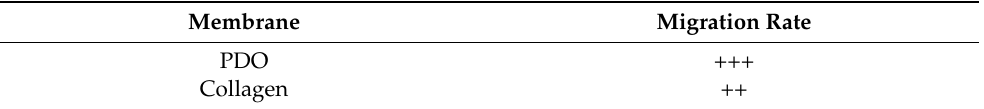
Table 3. Rate of hASC migration from the PDO and collagen membranes. ( − ) No migration;